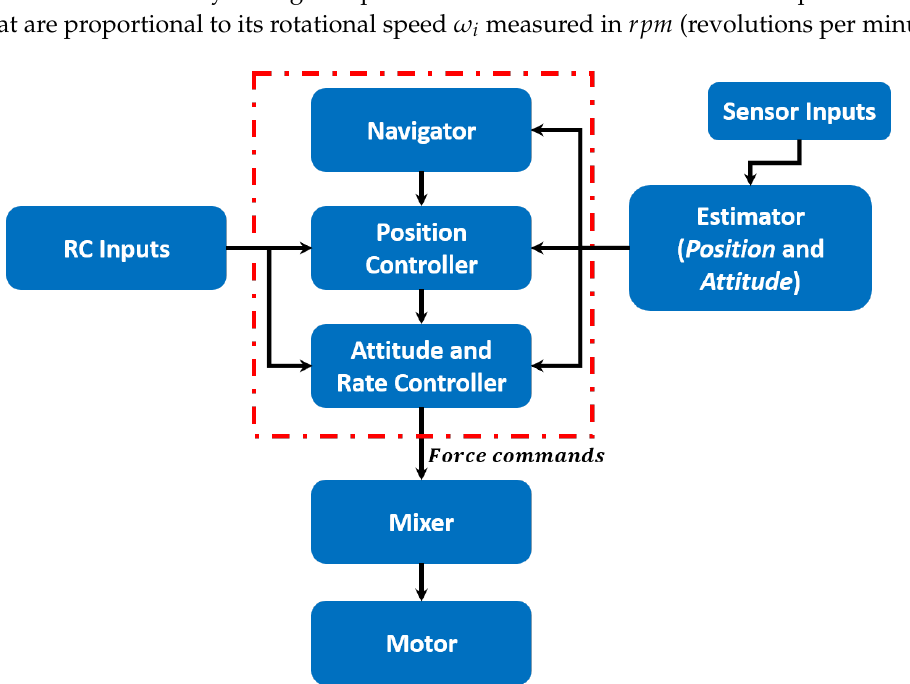
Figure 6. Unmanned aerial vehicle (UAV) Controller